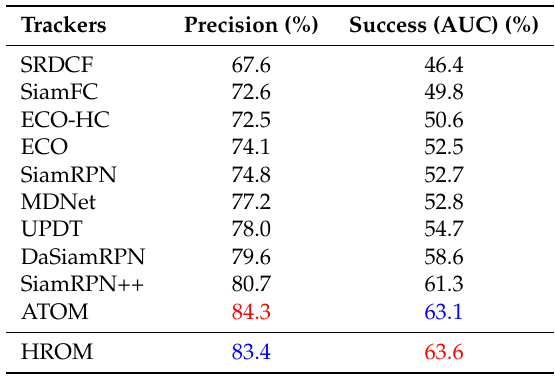
Table 5. Comparisons on UAV-123. Red and blue fonts indicate the top-2 trackers.